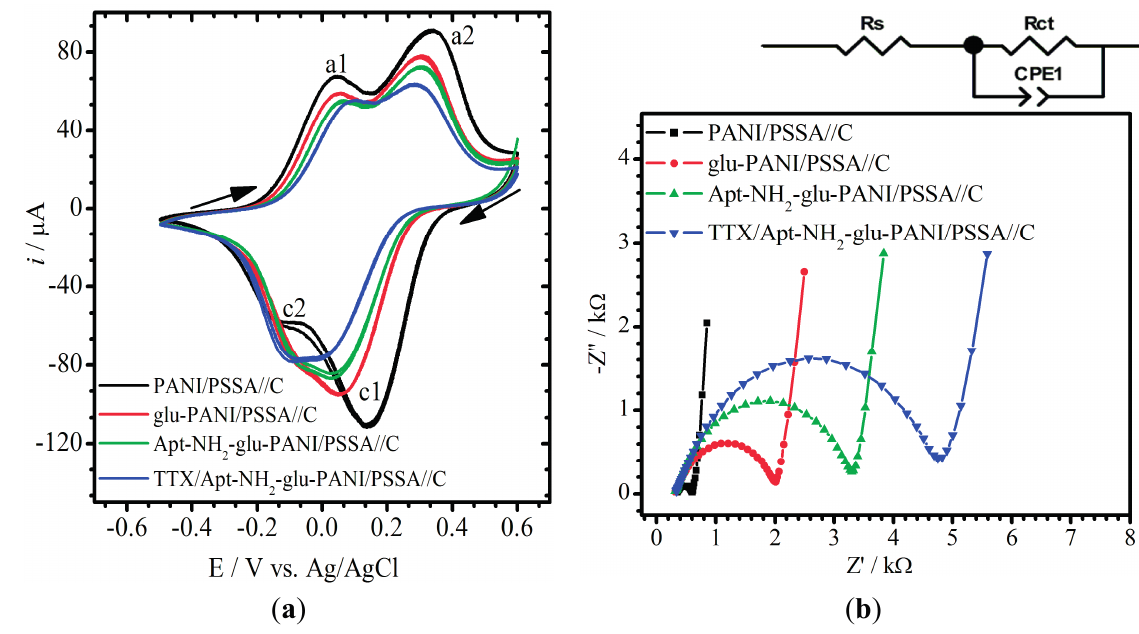
Figure 4. CVs ( a ) and EIS spectra ( b ) of TTX aptasensor and its electrode materials. Conditions: NaOAc buffer (0.1 M and pH 4.8); initial CV scan direction is cathodic; and EIS’s E = 0.010 V and f = 100 mHz–100 kHz. The equivalent circuit on top of ( b ) was used to fit the Nyquist plots ( R s , R ct and CPE1 are solution resistance, charge transfer resistance and constant phase element,